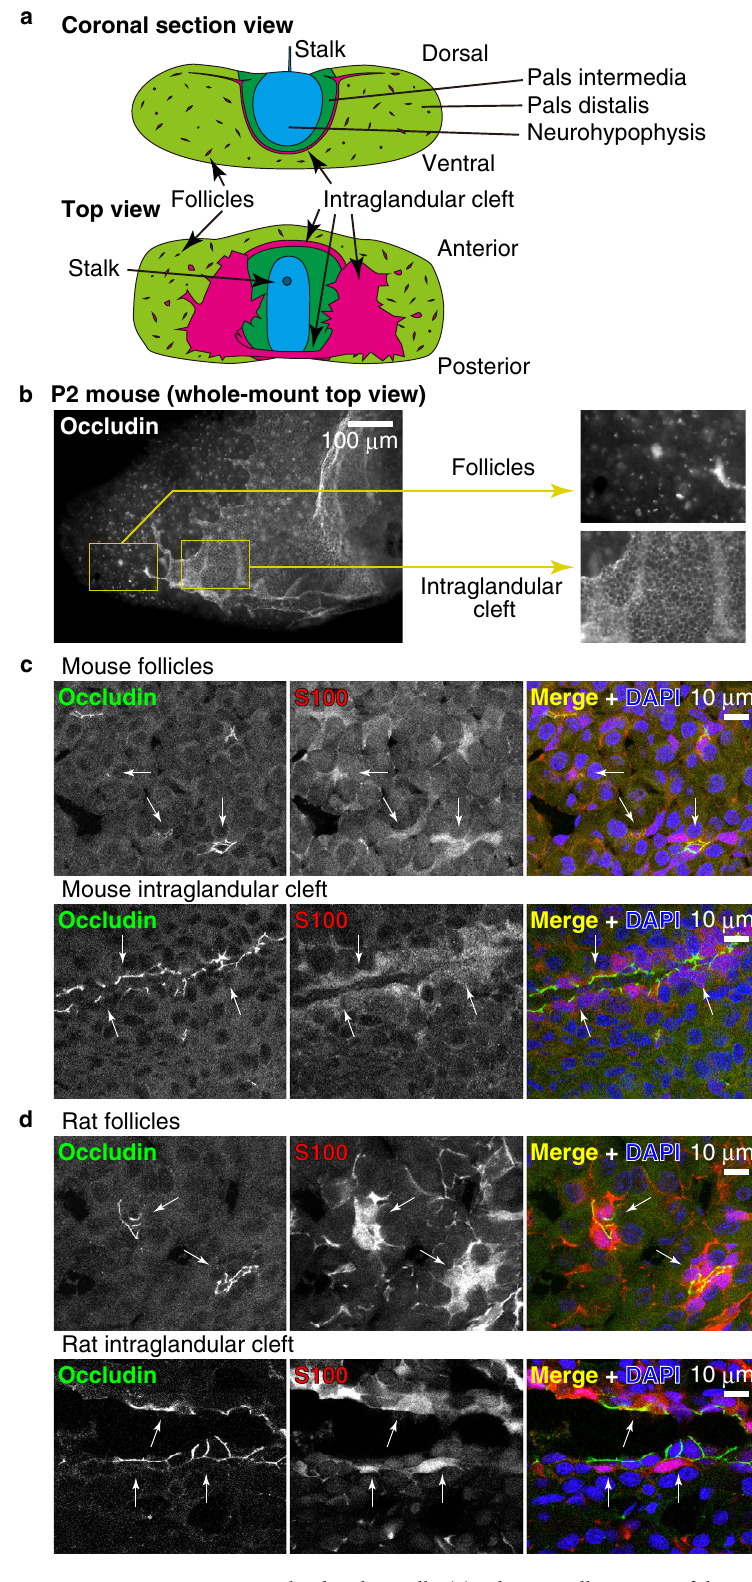
Figure 1. Anterior pituitary gland and FS cells. ( a ) Schematic illustration of the mouse pituitary gland. ( b ) Whole-mount staining of the pituitary gland of a mouse neonate (P2) using anti-occludin mAb. ( c ), ( d ) Immunostaining of frozen sections of the adult mouse ( c ) or adult rat ( d ) anterior pituitary gland using anti- occludin mAb, anti-S100 pAb, and